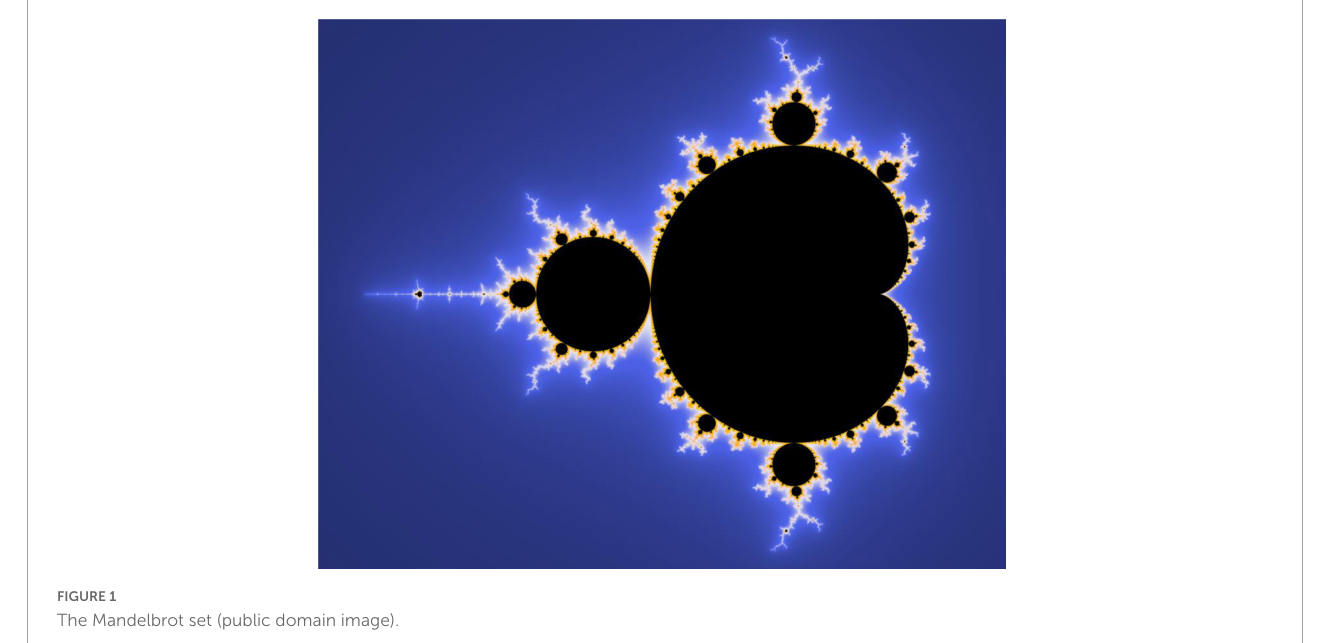
FIGURE1 The Mandelbrot set (public domain image).